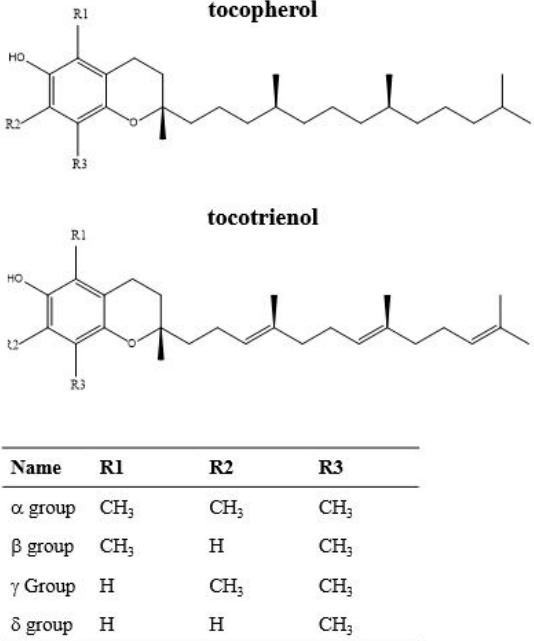
Figure 3. Tocopherol and tocotrienol chemical structures. The numbers and positions of methyl groups on the aromatic ring are reported in the table.